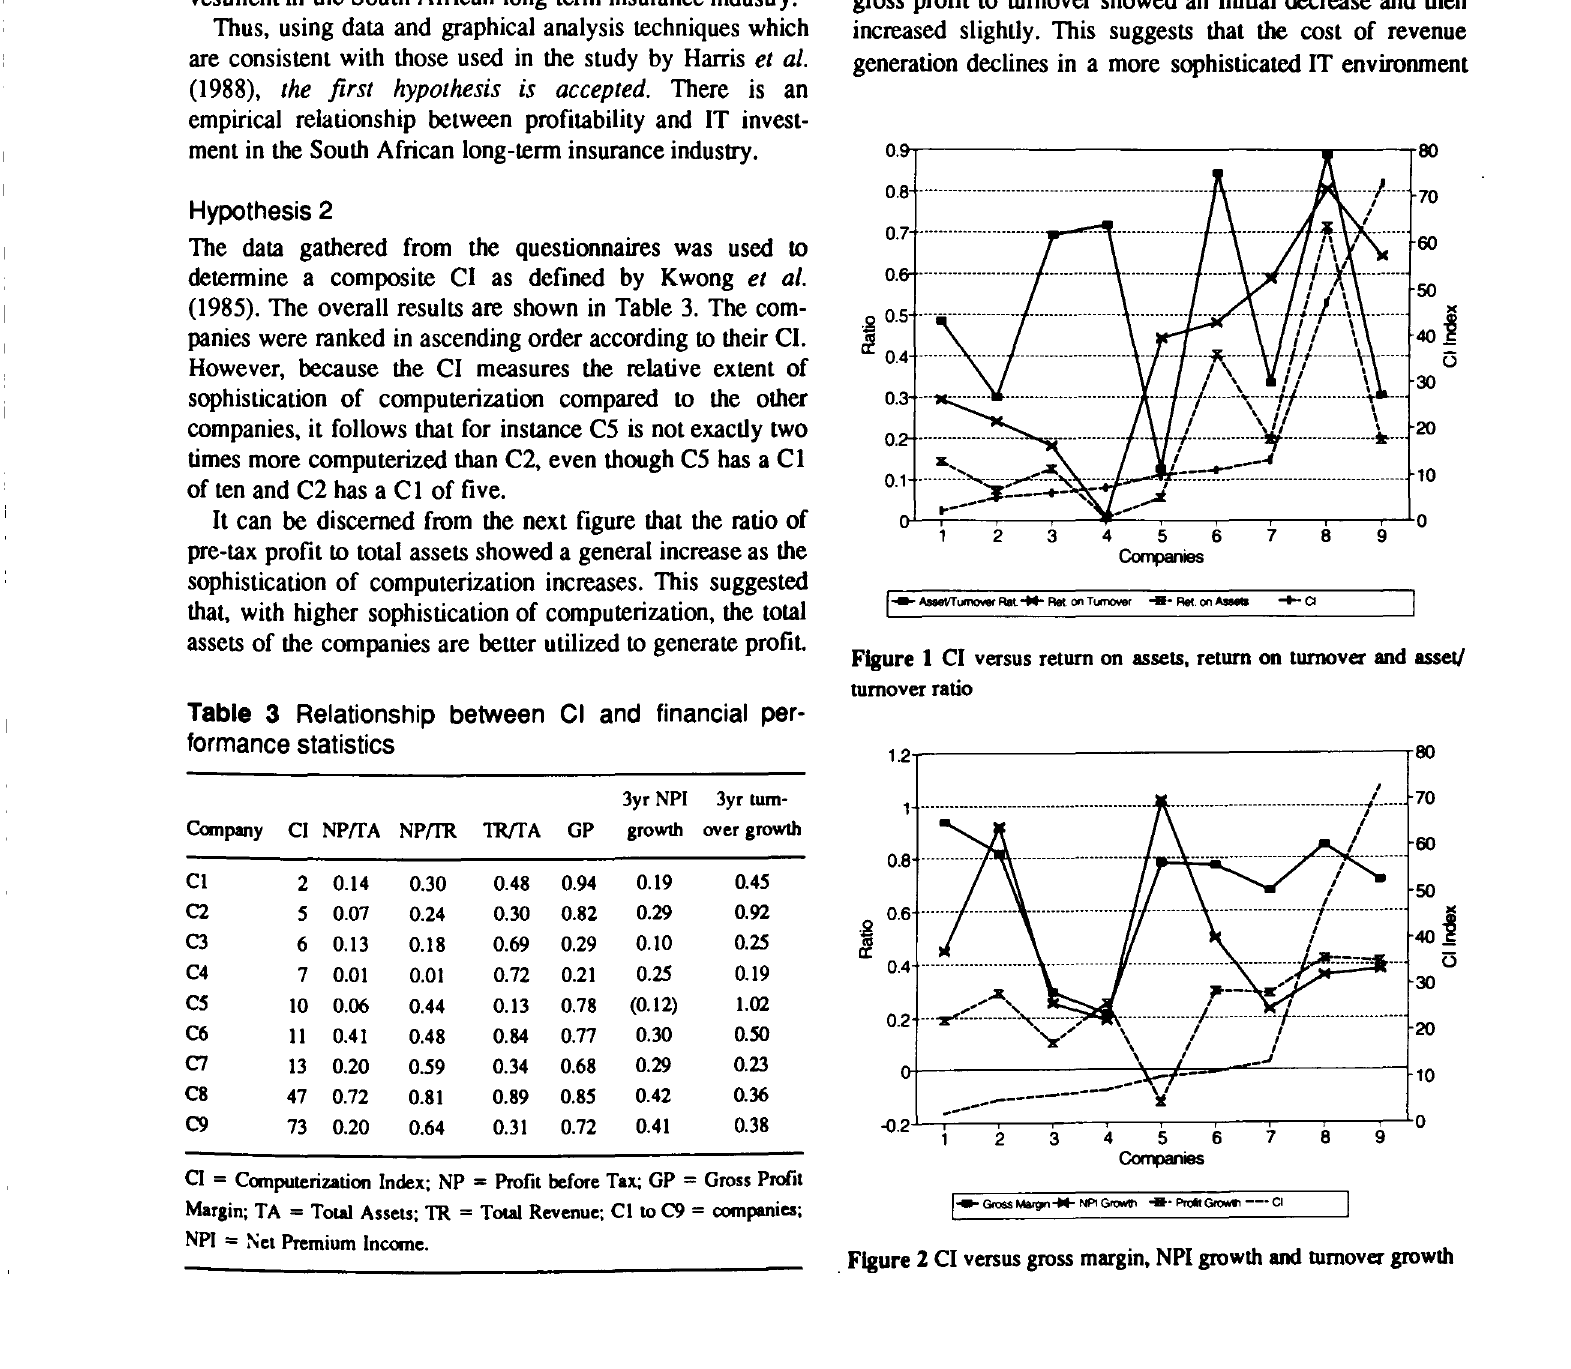
. Figure 2 CI versus gross margin, NPI growth and turnover